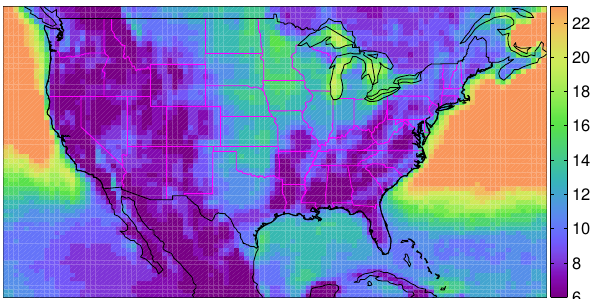
Fig. 8a. Geographical variation of the mean WPD (W m − 2 ) at 50m in the US. sides of the US have long median episodes of 20 h or